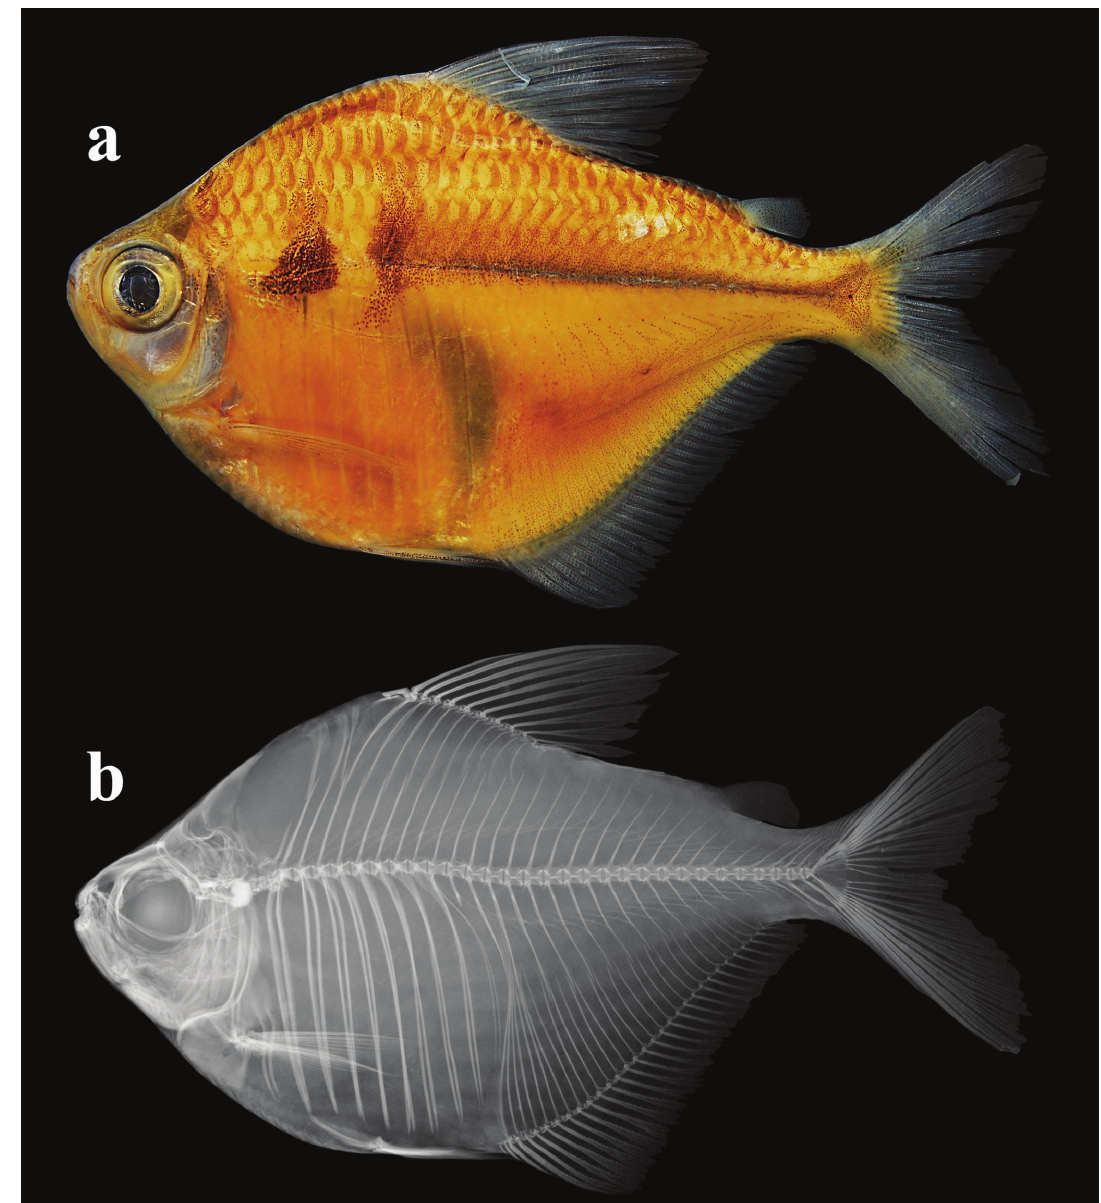
Fig. 1. a. Poptella actenolepis , holotype, MZUSP 124423, 71.9 mm SL, Brazil, Amazonas, Apuí, Rio Juma, Rio Madeira basin; b. radiograph of the